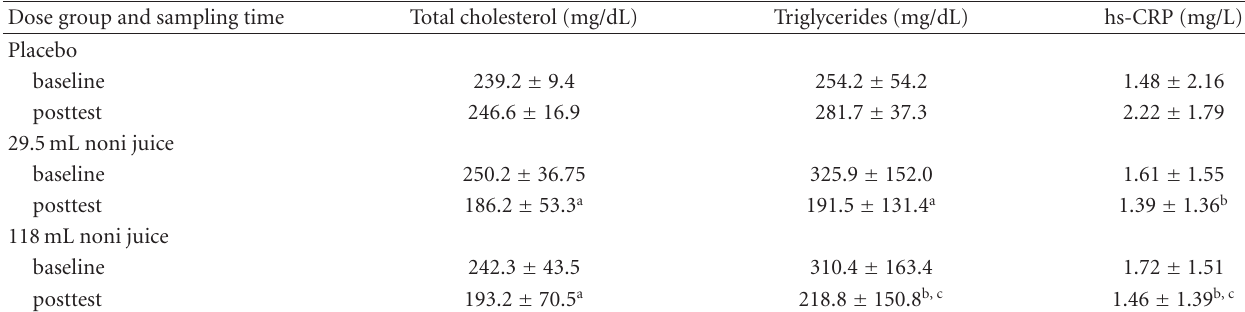
Table 1: Comparison of baseline and posttest serum measurements among placebo and noni juice